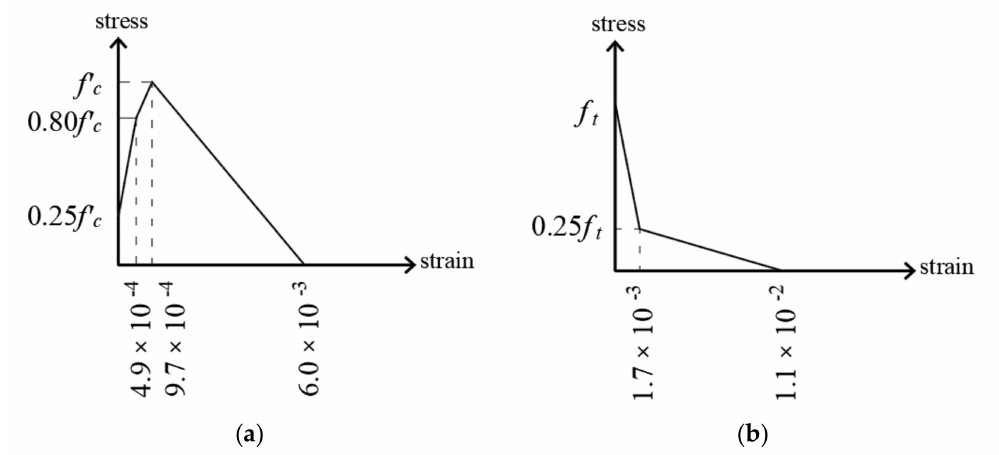
Figure 2. Concrete material model: ( a ) Compressive behavior; ( b ) tensile